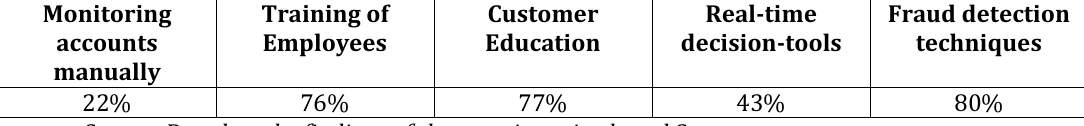
Table 10: Responses about Detection and Prevention of Frauds in Banks